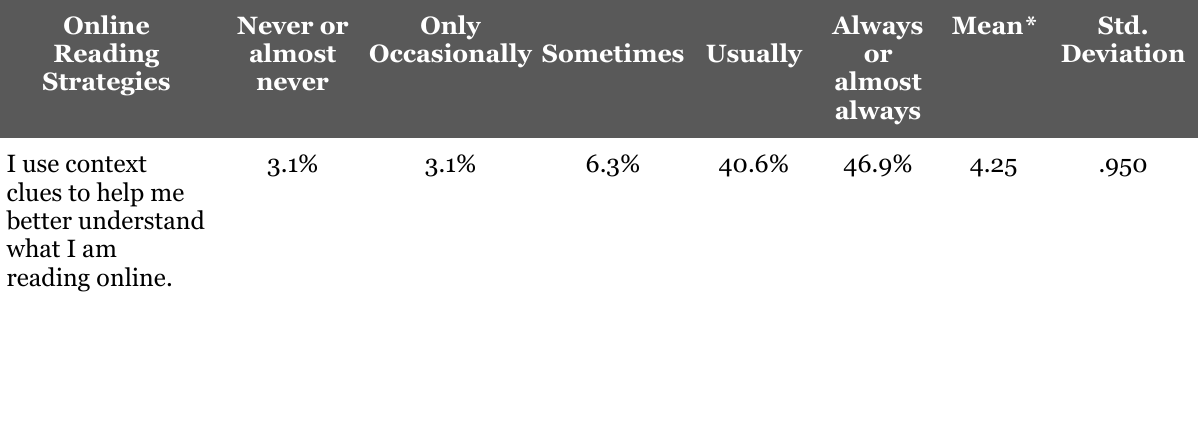
Table 2 Most Frequently Used Strategies by Language Learners for Online Reading in Foreign